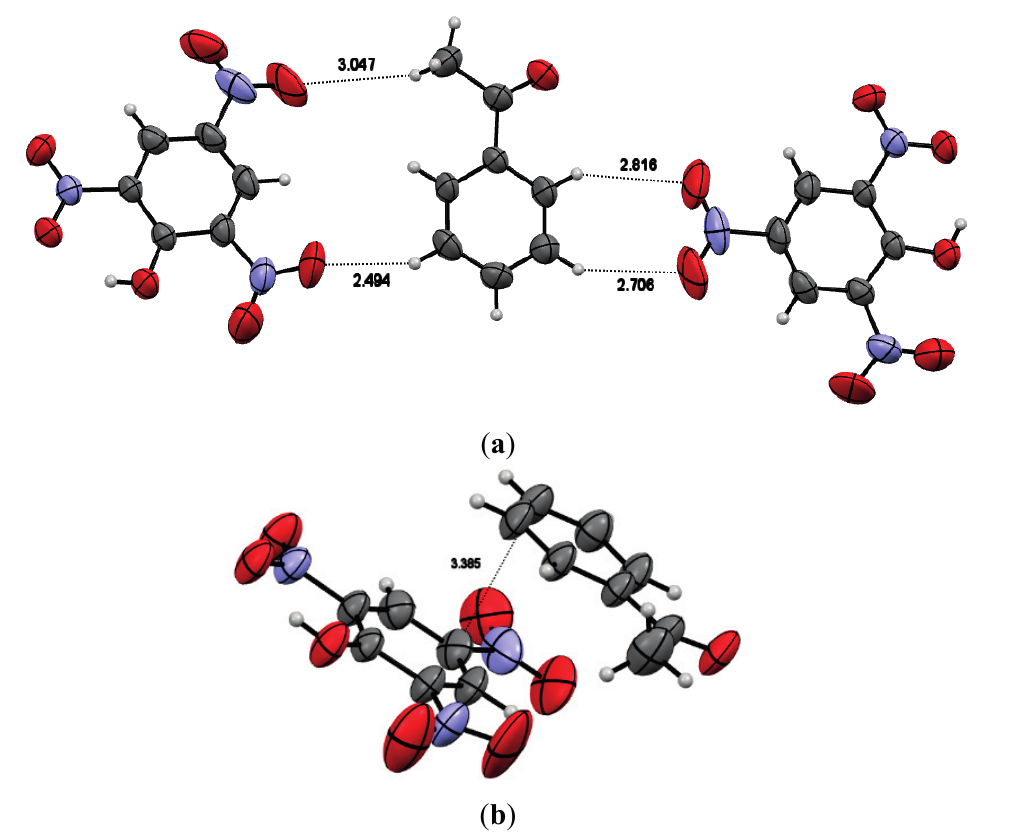
Figure 1. Intermolecular interactions between picric acid and acetophenone in the cocrystal: ( a ) hydrogen bonding; ( b ) π - π stacking. Displacement ellipsoids are drawn at the 50%